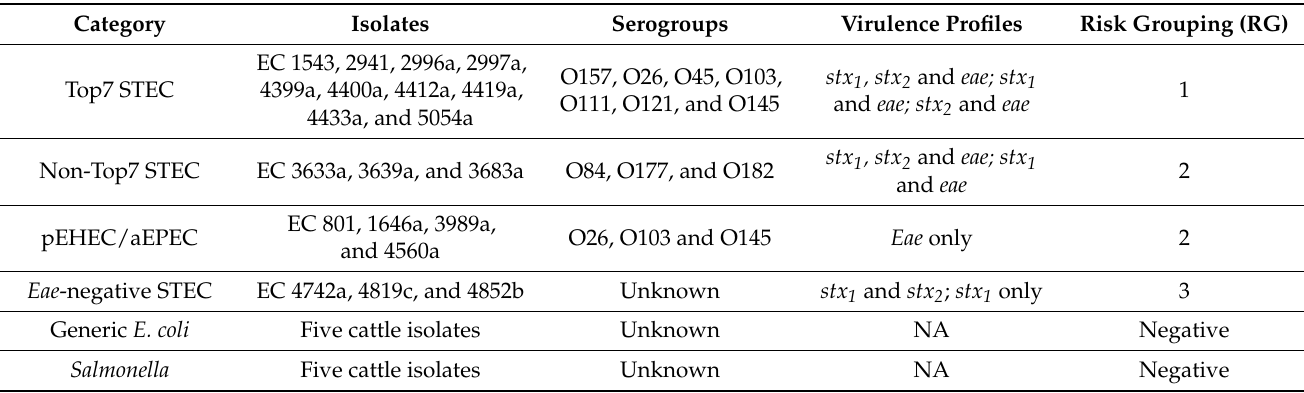
Table 1. Category, serogroup, virulence profile, and risk groupings of isolates included in the study. Note: The column “Isolates” refer to ID of individual strains from CSIRO the CSIRO STEC culture collection.